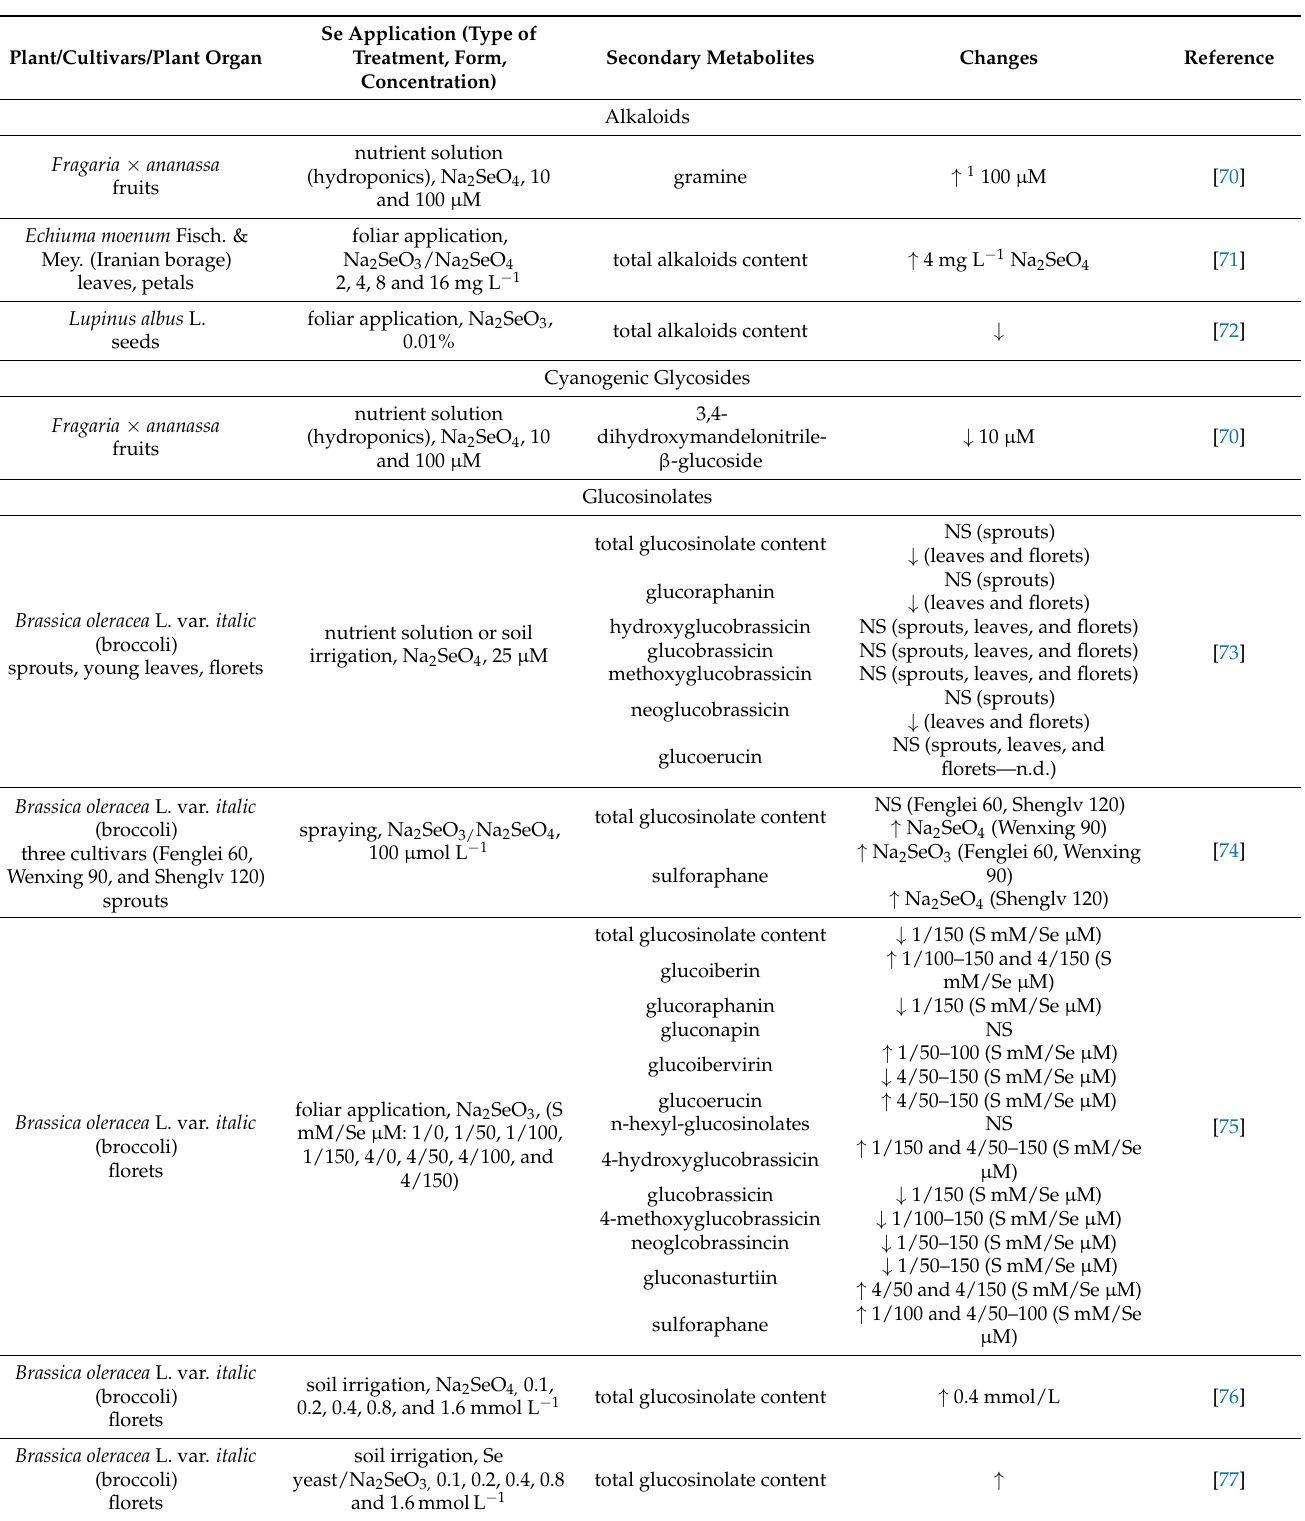
Table 1. Effect of Se application on the accumulation of alkaloids, cyanogenic glycosides, and